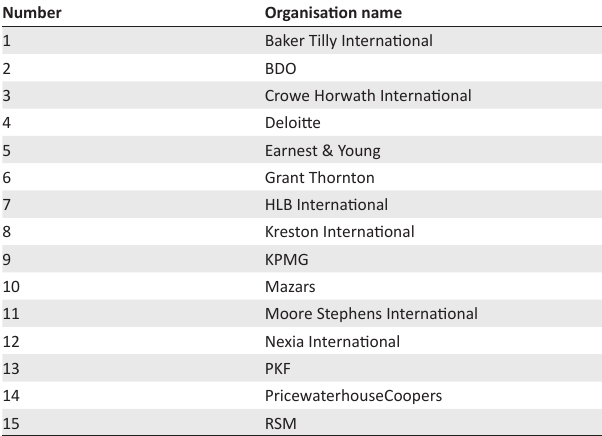
TABLE 2: The 15 audit firms, in alphabetical order, that were included in the sample. Number